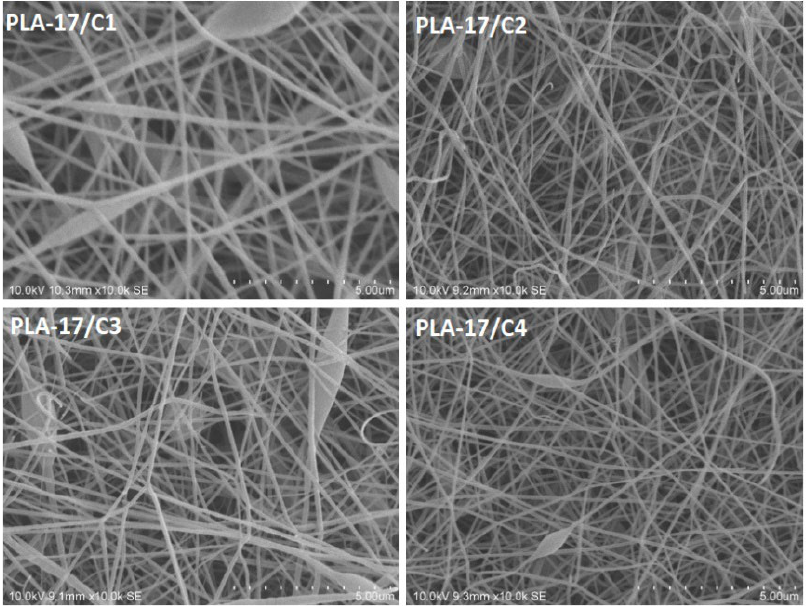
Figure 4. SEM images of 17% PLA nanofibers with variations in the CNDs of 1, 2, 3, and 4% (scale—5 µ m).